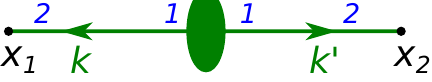
Figure 2 . The classical correlation function from eq. (2.3) or eq. (2.5) with the green oval denoting all the possible contributing Feynman diagrams (like the ‘square’ of the one shown in (cid:12)gure 1). Solid lines from now on represent the scalar (cid:12)eld. The indices 1 and 2 denote the type of the propagator in the Schwinger-Keldysh